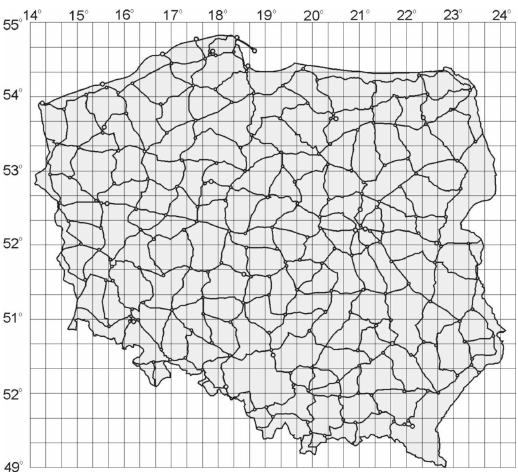
Fig 8. The grid of meridians and parallels 20’×20’ against the background of Poland’s borders and the double levelling